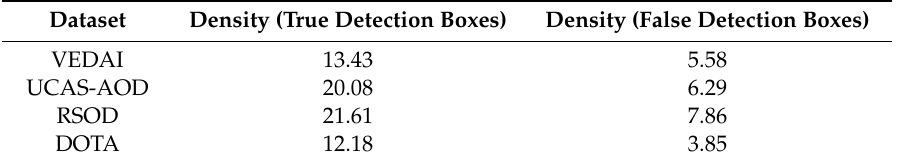
Figure 2. Comparison of the results of the classical NMS and dual-NMS. ( a ) Outputs of the detection network with no post-processing operations. ( b ) Detection results where the false detection boxes have been removed by the dual-NMS. ( c ) The classical NMS algorithm removes the overlapped detection boxes, but fails to remove the false detection boxes. ( d ) The detection results that were processed by the dual-NMS, where the false detection boxes have been correctly removed. Table 1. The average density of the true and false detection boxes in different datasets.